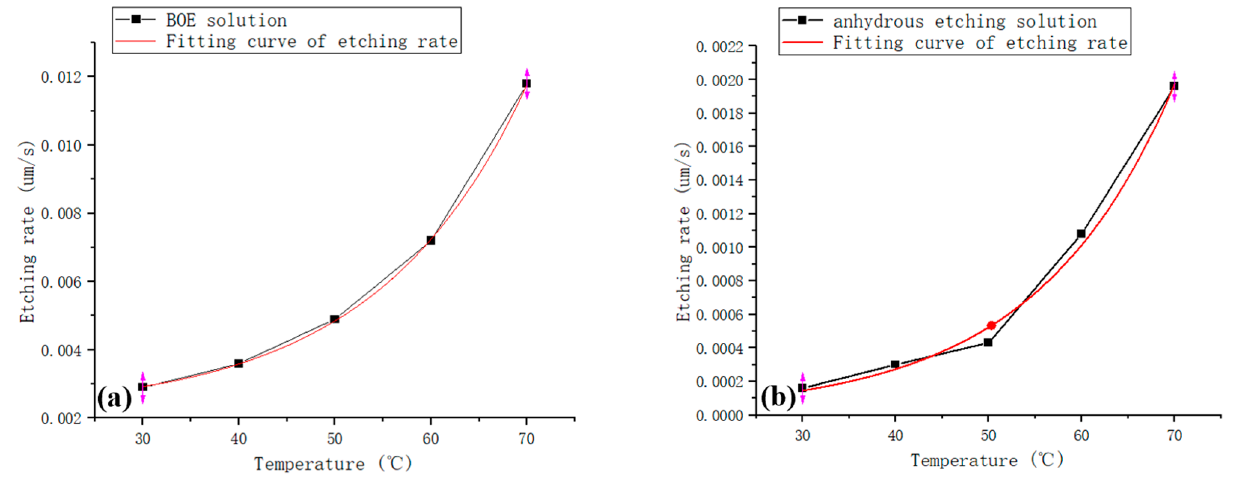
Figure 3. Temperature–etching rate relationship: ( a ) BOE solution; ( b ) anhydrous etching solution.